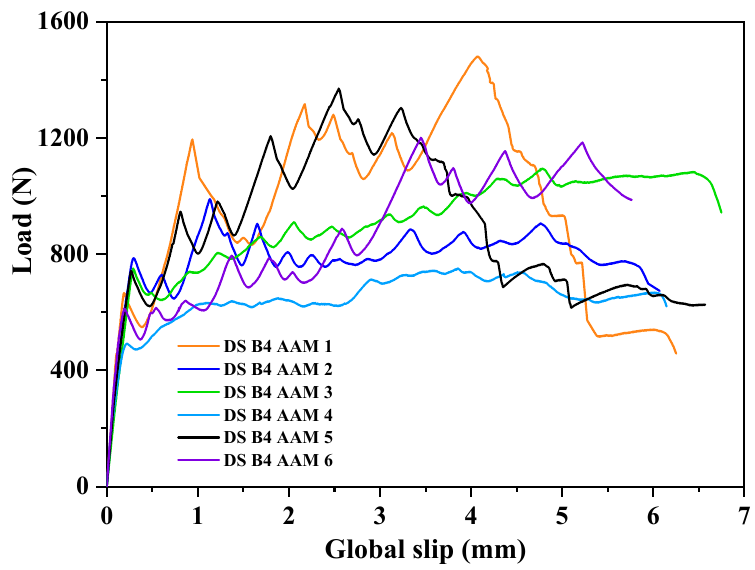
Figure 15. Direct shear test: load-global slip response curves. Table 6. Results of direct shear